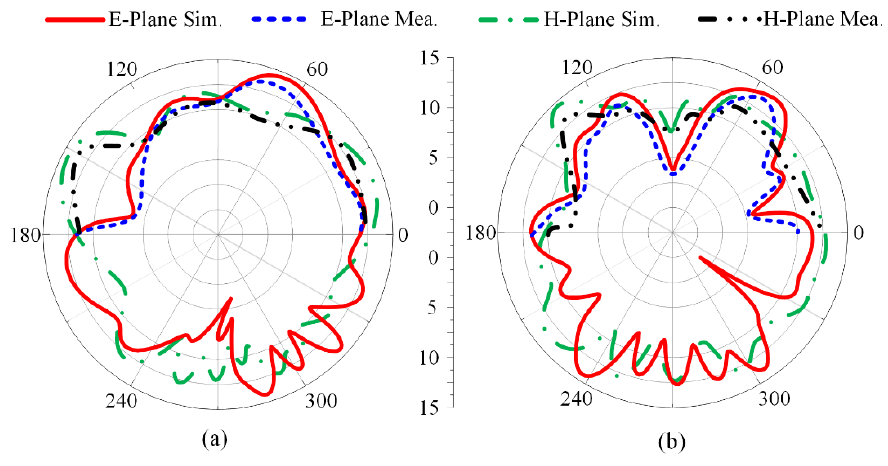
Figure 12. Measured and simulated radiation patterns of proposed parasitic element-loaded dual- band MIMO antenna at ( a ) 28 GHz and ( b ) 38 GHz.